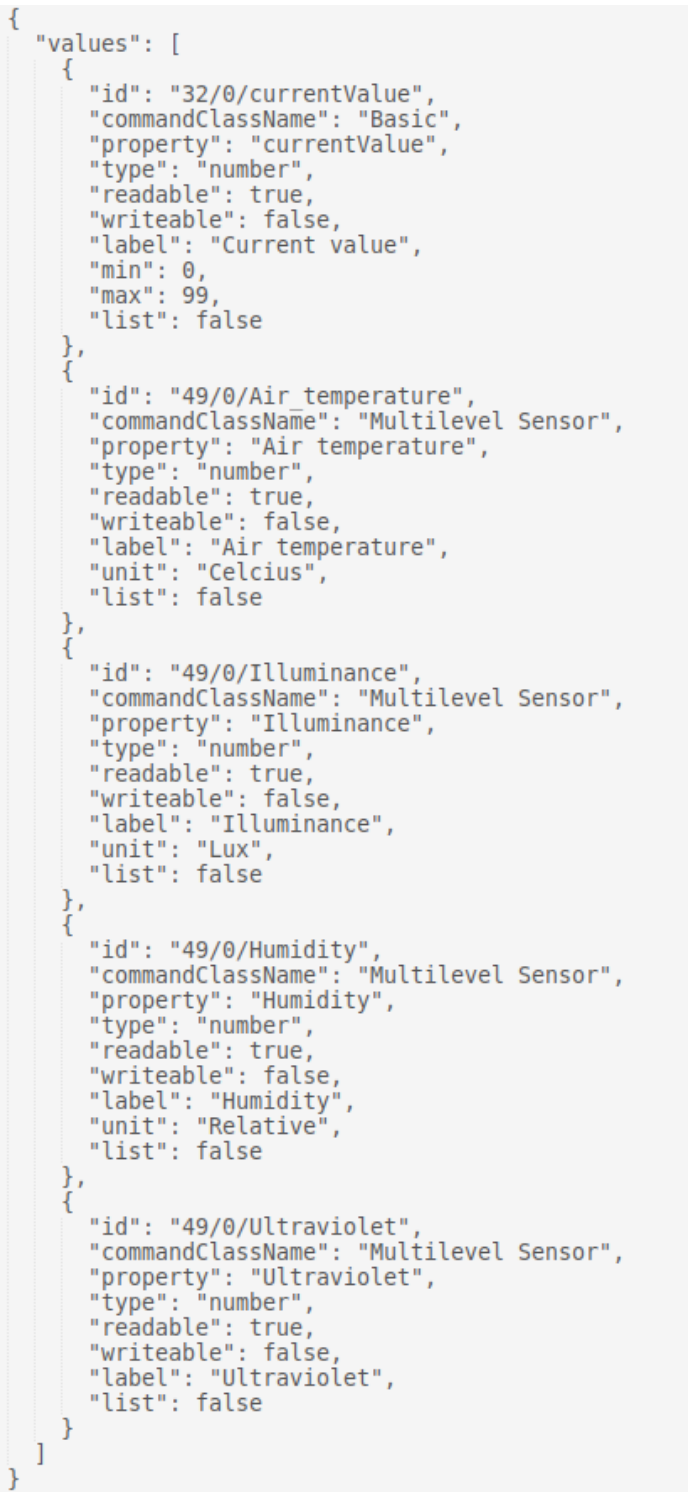
Figure 6. Z-Wave